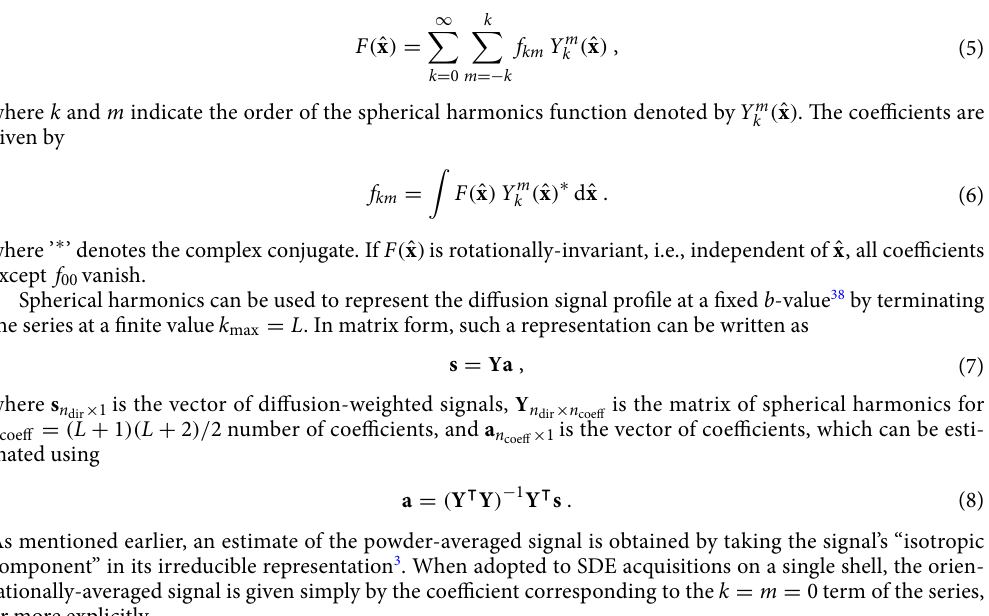
where k and m indicate the order of the spherical harmonics function denoted by Y m k (